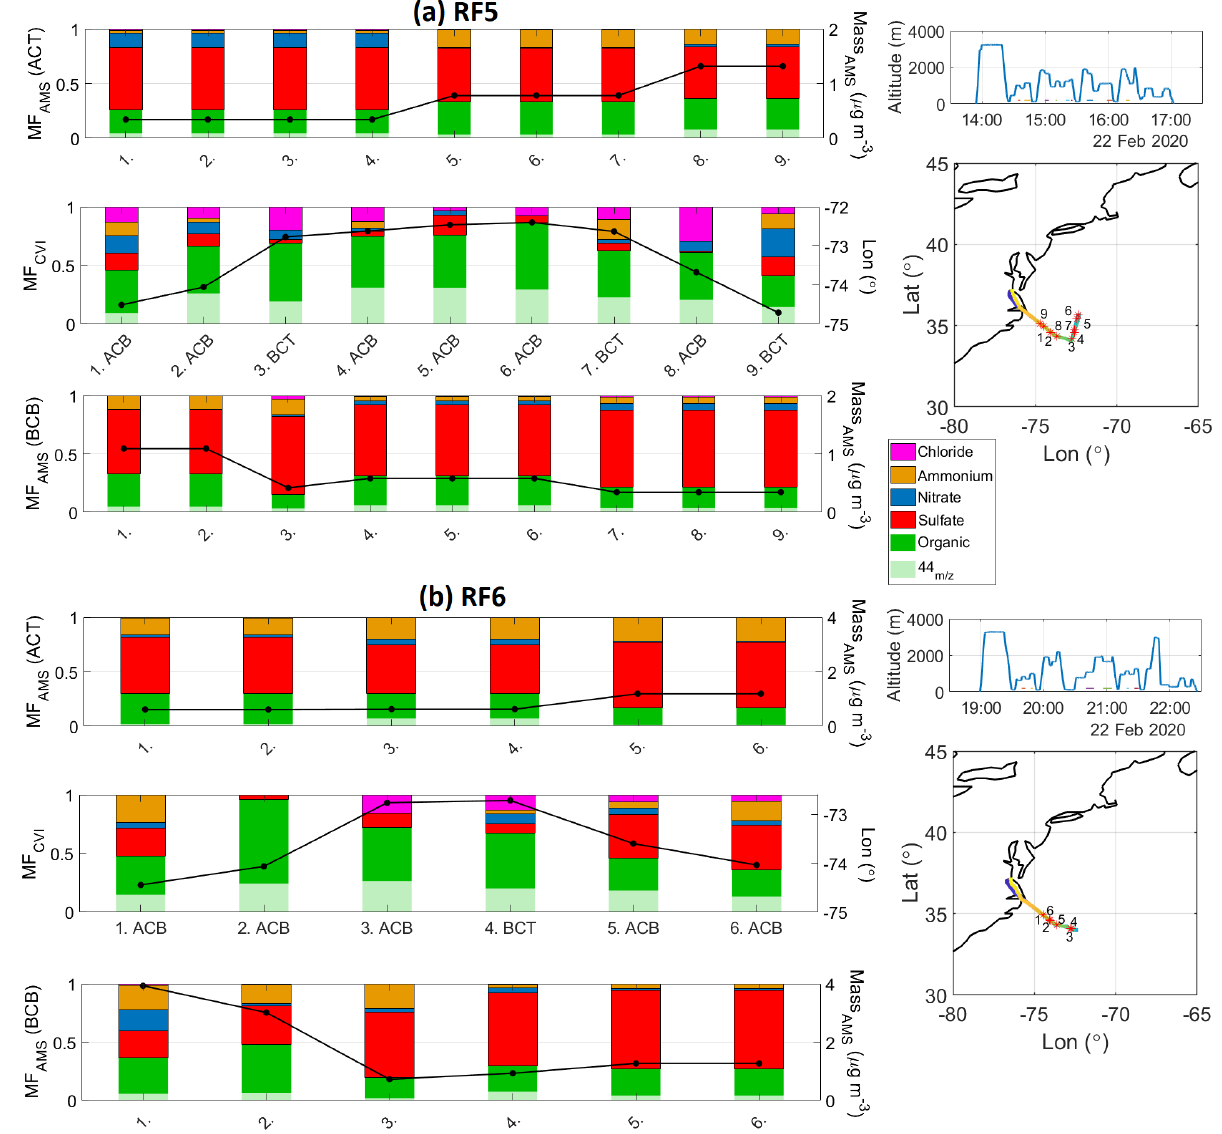
Figure 10. Summary of AMS composition in adjacent BCB, cloud, and ACT legs during back-to-back flights (research flights 5 and 6) in CAO conditions on 22 February 2020. Shown in the bar charts are the mass fractions of AMS components in addition to either total AMS mass (for ACT and BCB legs; such data are not robust for CVI legs due to how the CVI operates) or longitude on the right y axis. Note that some BCB and ACT legs are repeated for different cloud legs as they represent the closest leg to an individual cloud leg. On the far right are Falcon altitude time series along with the spatial map with numbers corresponding to the leg numbers in the bar